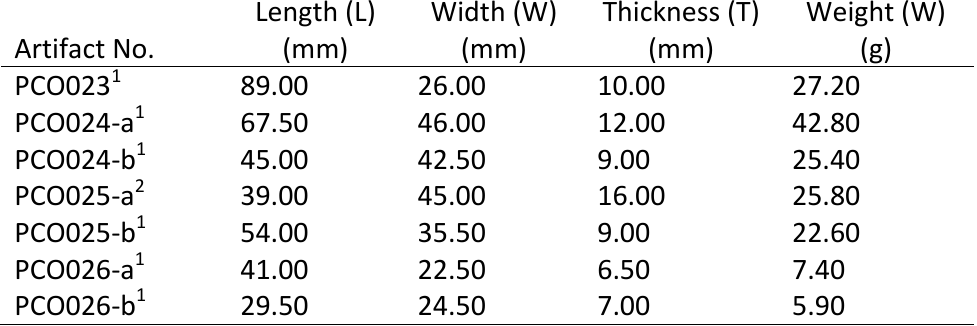
Table 2. Metric variables recorded in the blades analyzed from Picão